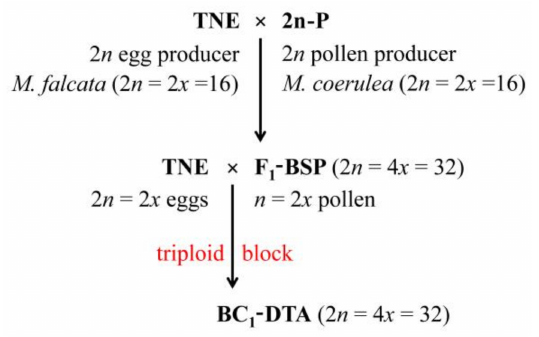
Figure A1. Strategy used for the introgression at the tetraploid level of the unreduced egg trait (TNE: diploid two— n —egg mutant; 2 n –P: diploid 2 n –pollen mutant; F 1 –BSP: tetraploidized hybrid progeny plants deriving from bilateral sexual polyploidization schemes; BC 1 –DTA: first generation backcross progeny including diplosporic tetraploidized alfalfa